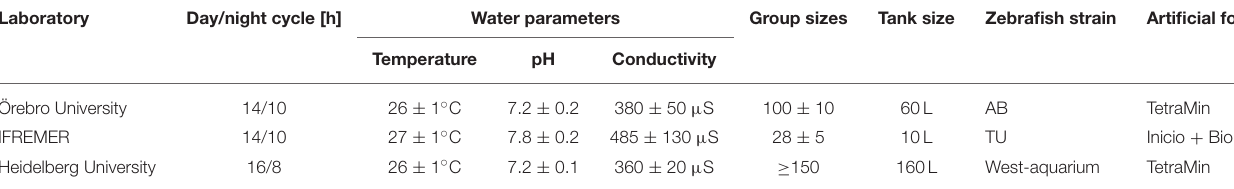
TABLE 1 | Husbandry conditions of zebrafish in the three participating laboratories. Laboratory